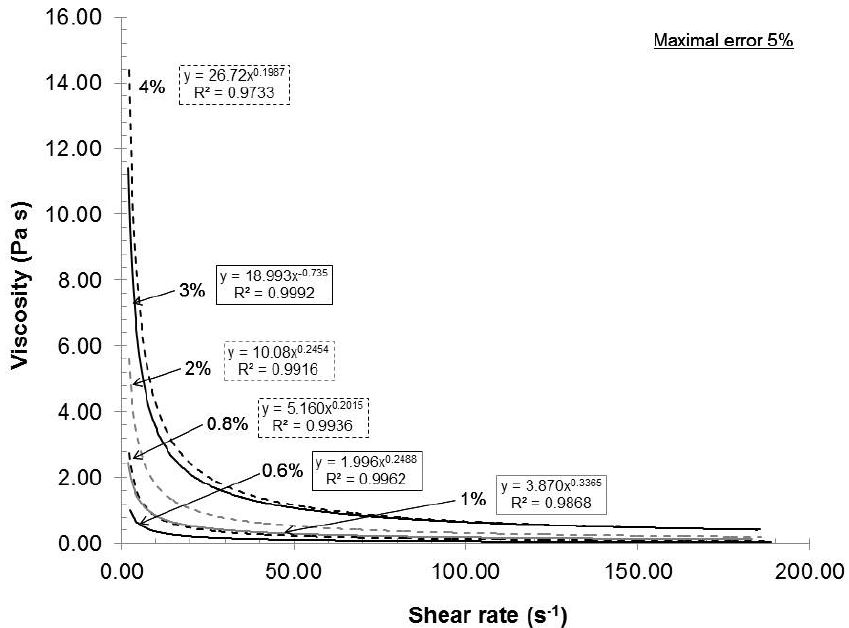
Figure 3. Effect of consistency on the viscosity of the